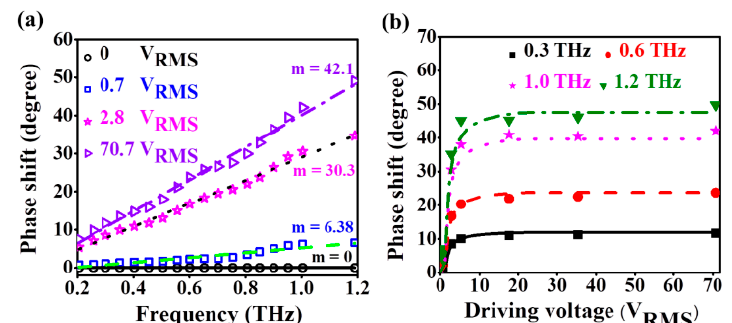
Figure 5. Phase shift properties as a function of ( a ) frequency for several values of applied voltage and ( b ) applied voltage at selected frequencies for an MDA-250 TN-LC-based THz phase shifter. The slope of the linear line fitting experimental data is denoted by m. The circles, squares, diamonds, and triangles are experimental data. The solid line, dash line, dot line, and dash–dot line are ( a ) linear fit and ( b ) theoretical curves.